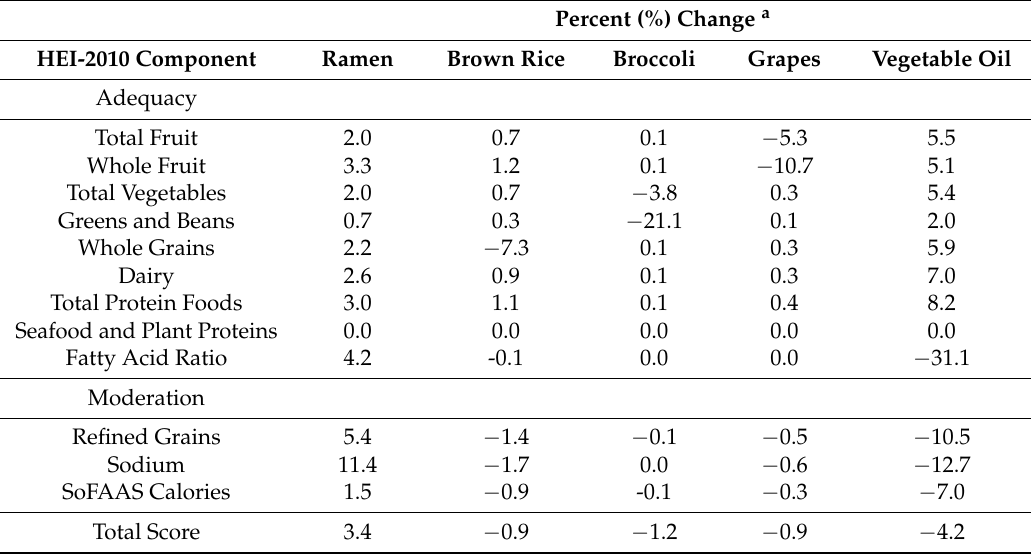
Table 4. Criterion validity testing: percent (%) change values for HEI-2010 components and total score when specified food was removed from the Home-IDEA2 HEI Score database for 5 example